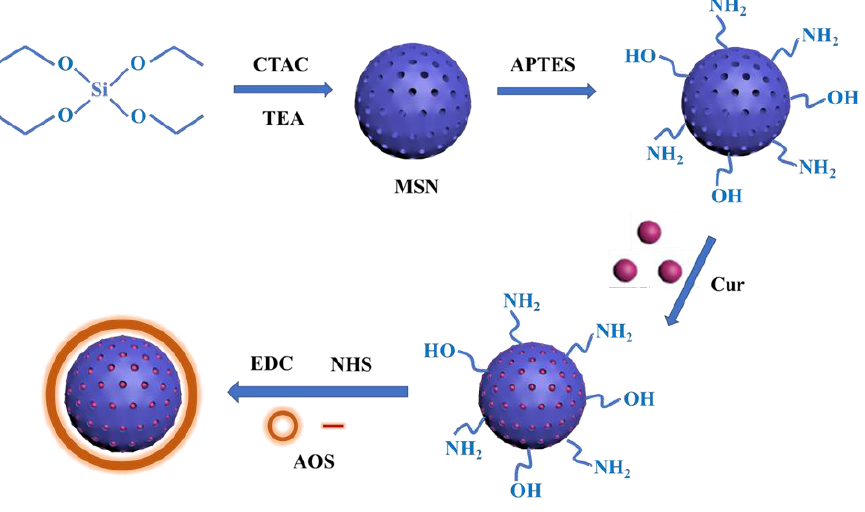
Figure 1. Preparation of MSN-NH 2 -Cur-AOS nanoparticles.